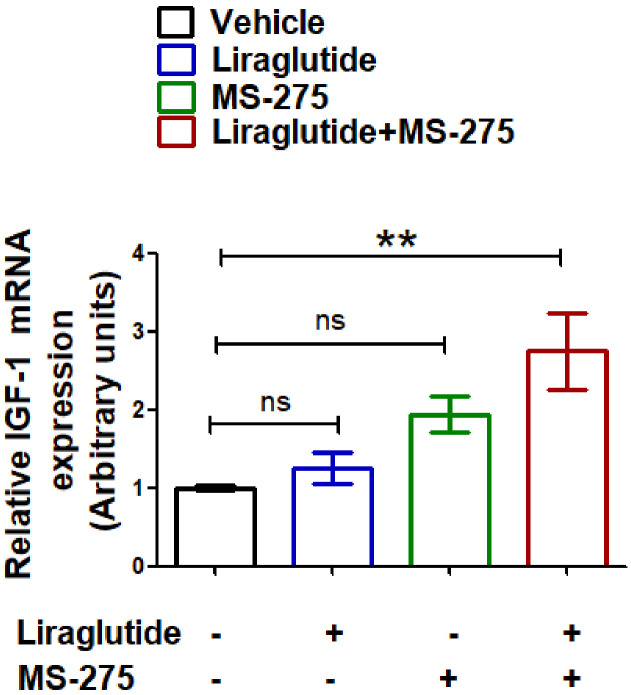
Effect of MS-275, liraglutide monotherapy, and combined therapy or the vehicle control on the IGF1 expression in liver, n = 4; the data represent mean ± S.E.**p<0.01, as determined by one-way ANOVA, Tukey’s multiple comparison test; ns: non-significant.